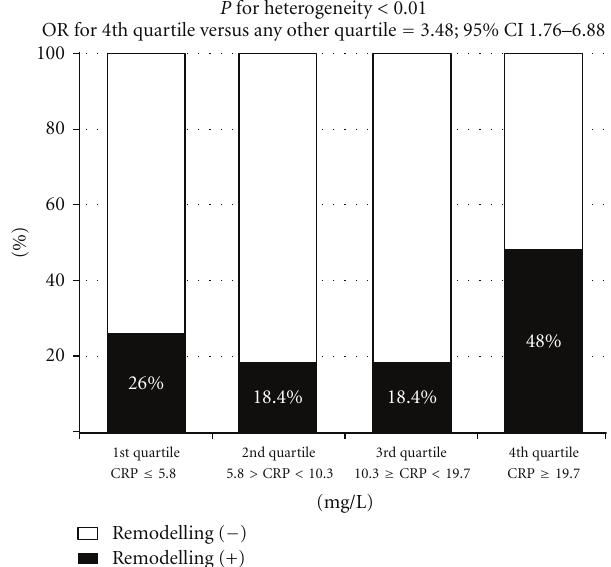
Figure 2: Prevalence of left ventricular remodelling at 6 months after hospital discharge after acute ST-segment elevation myocardial infarction in patients classified according to the increasing quartiles of C-reactive protein concentration 24 h after admission. CRP— C- reactive